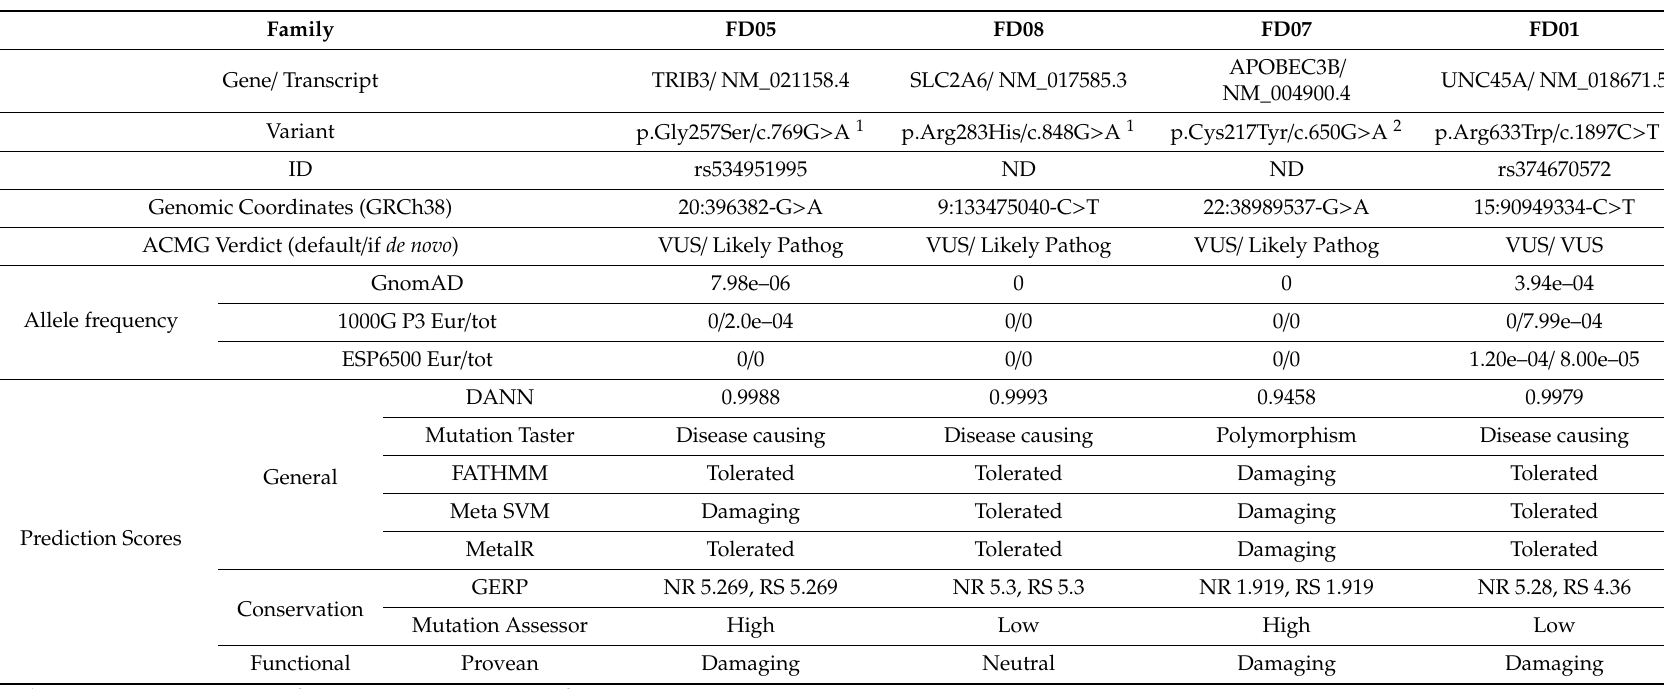
Table 2. Molecular characteristics of variants of interest in novel genes from whole exome sequencing (WES) analysis in trios found in